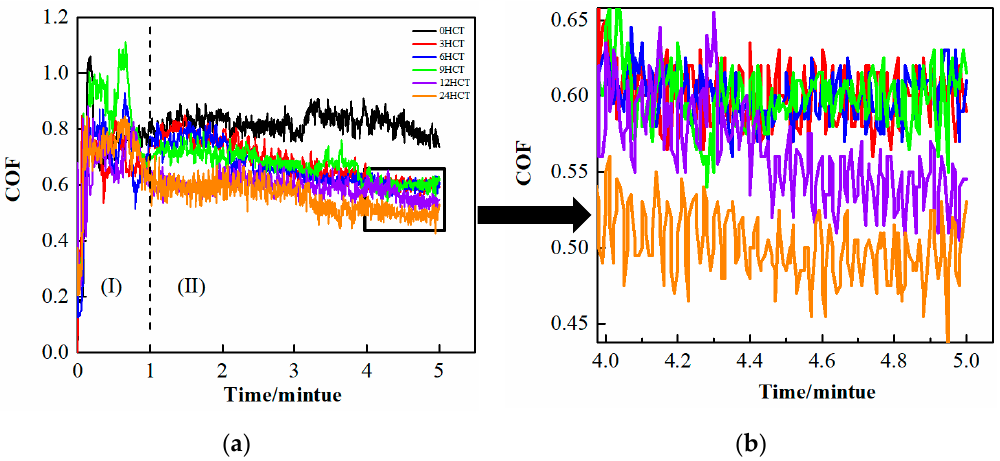
Figure 6. Coefficient of friction (COF) of the cladding coating in wear tests: ( a ) COF of the cladding coatings; ( b ) partial enlarged detail of COF curves.